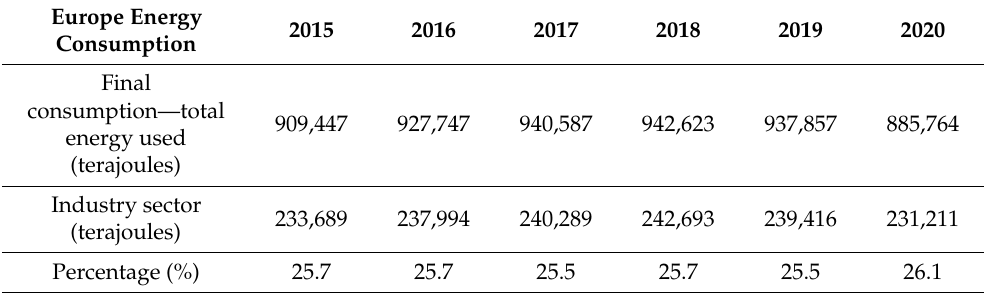
Table 1. Energy consumption in the last 5 years in Europe